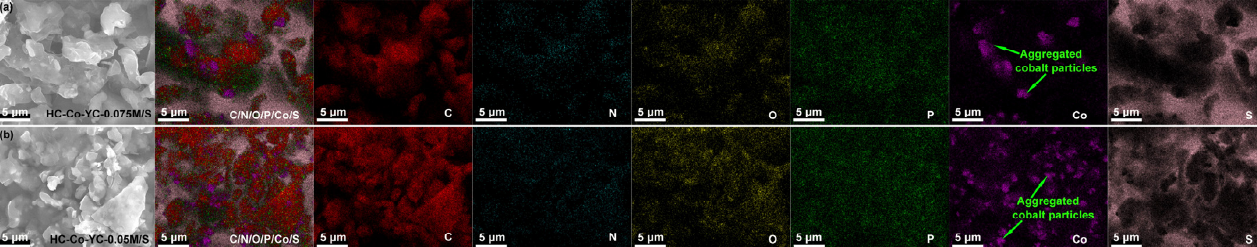
Figure 5. SEM images and corresponding elemental mappings of ( a ) HC–Co–YC–0.075M/S and ( b ) HC–Co–YC–0.05M/S composites.